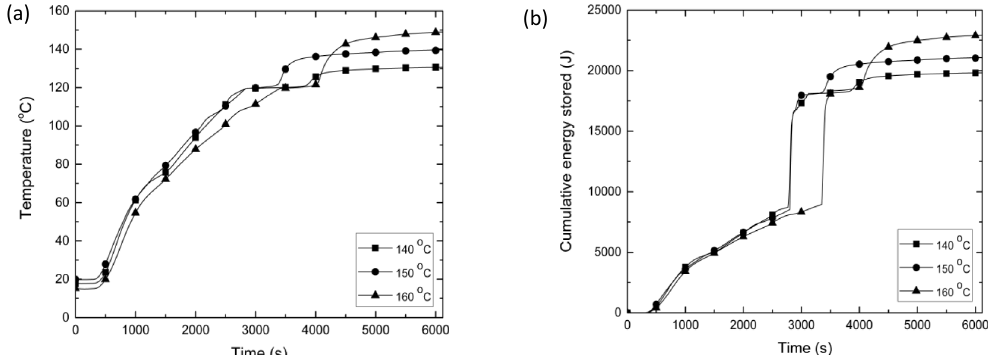
Fig. 4. (a) Average temperature histories of the EPCM and (b) the cumulative thermal energy stored by the EPCM while charging at with maximum HTF inlet temperature set at 140, 150 and 160 ° C with HTF fl ow rate of